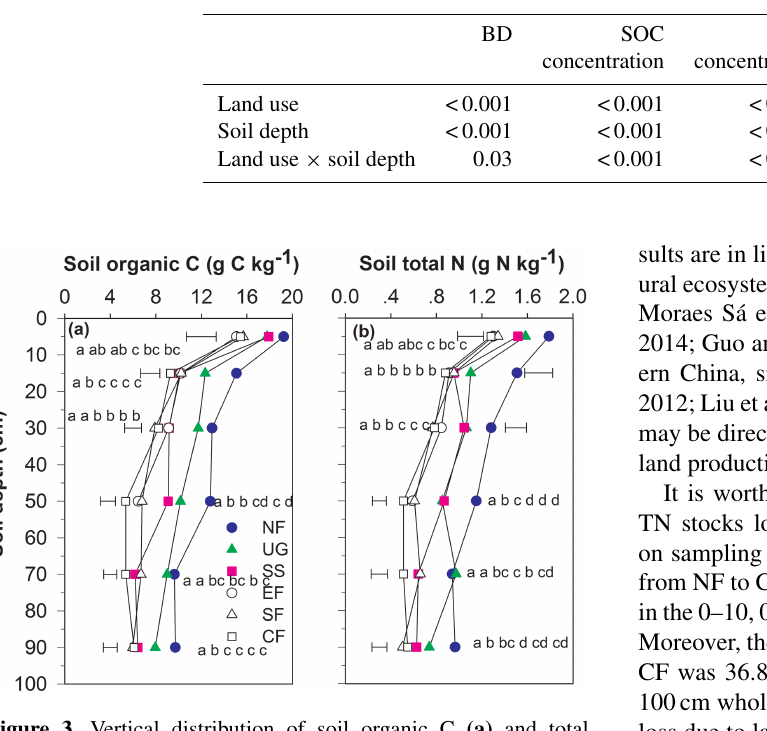
Figure 3. Vertical distribution of soil organic C (a) and total N (b) concentrations as influenced by changes in land-use types (NF, native forest; UG, unused grassland; SS, secondary shrub; EF, eucalyptus forest; SF, sugarcane field; CF, corn field). Error bars represent LSD calculated by one-way ANOVA at P = 0.05 level ( N = 5), and different lowercase letters indicated significant changes between land-use types within soil depth (Note: letters from left to right stand for NF, UG, SS, EF, SF and CF, respec-